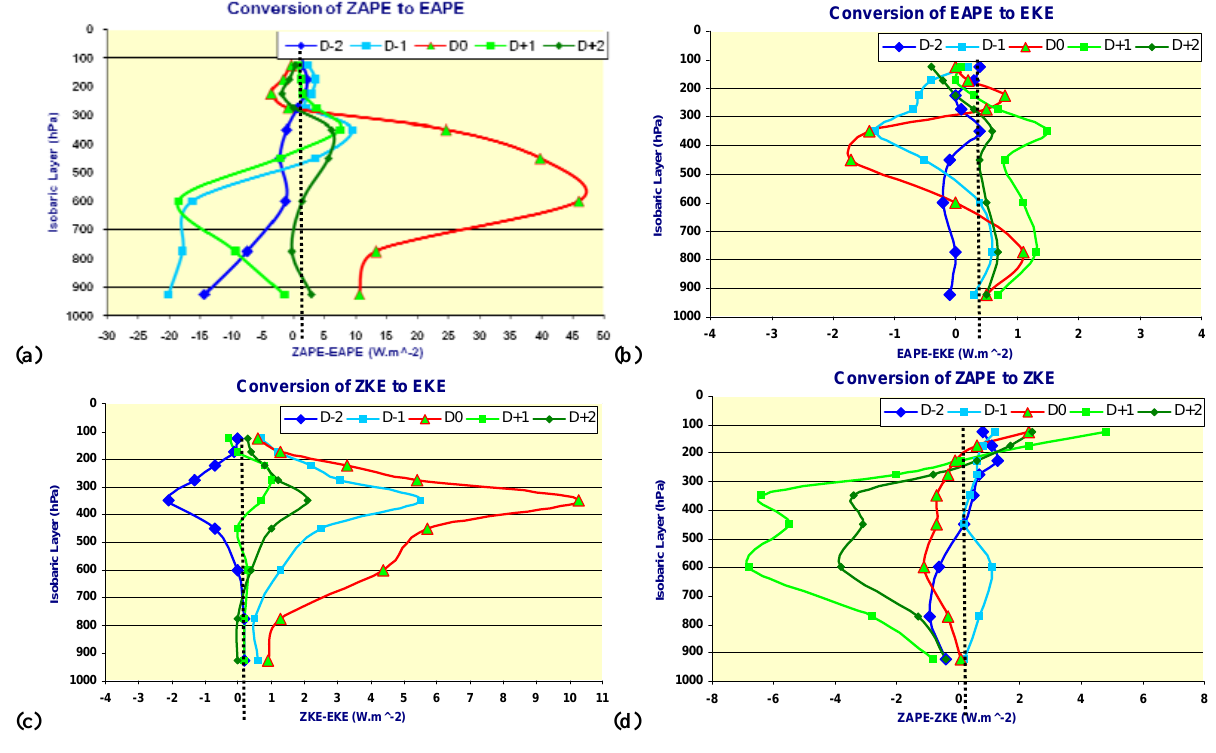
Fig. 14. Energy conversions of (a) ZAPE to EAPE, (b) EAPE to EKE, (c) ZKE to EKE, and (d) ZAPE to ZKE (d) on 27 (D-2), 28 (D-1), 29 (D0), 30 (D+1) and 31 January 2008 (D+2).